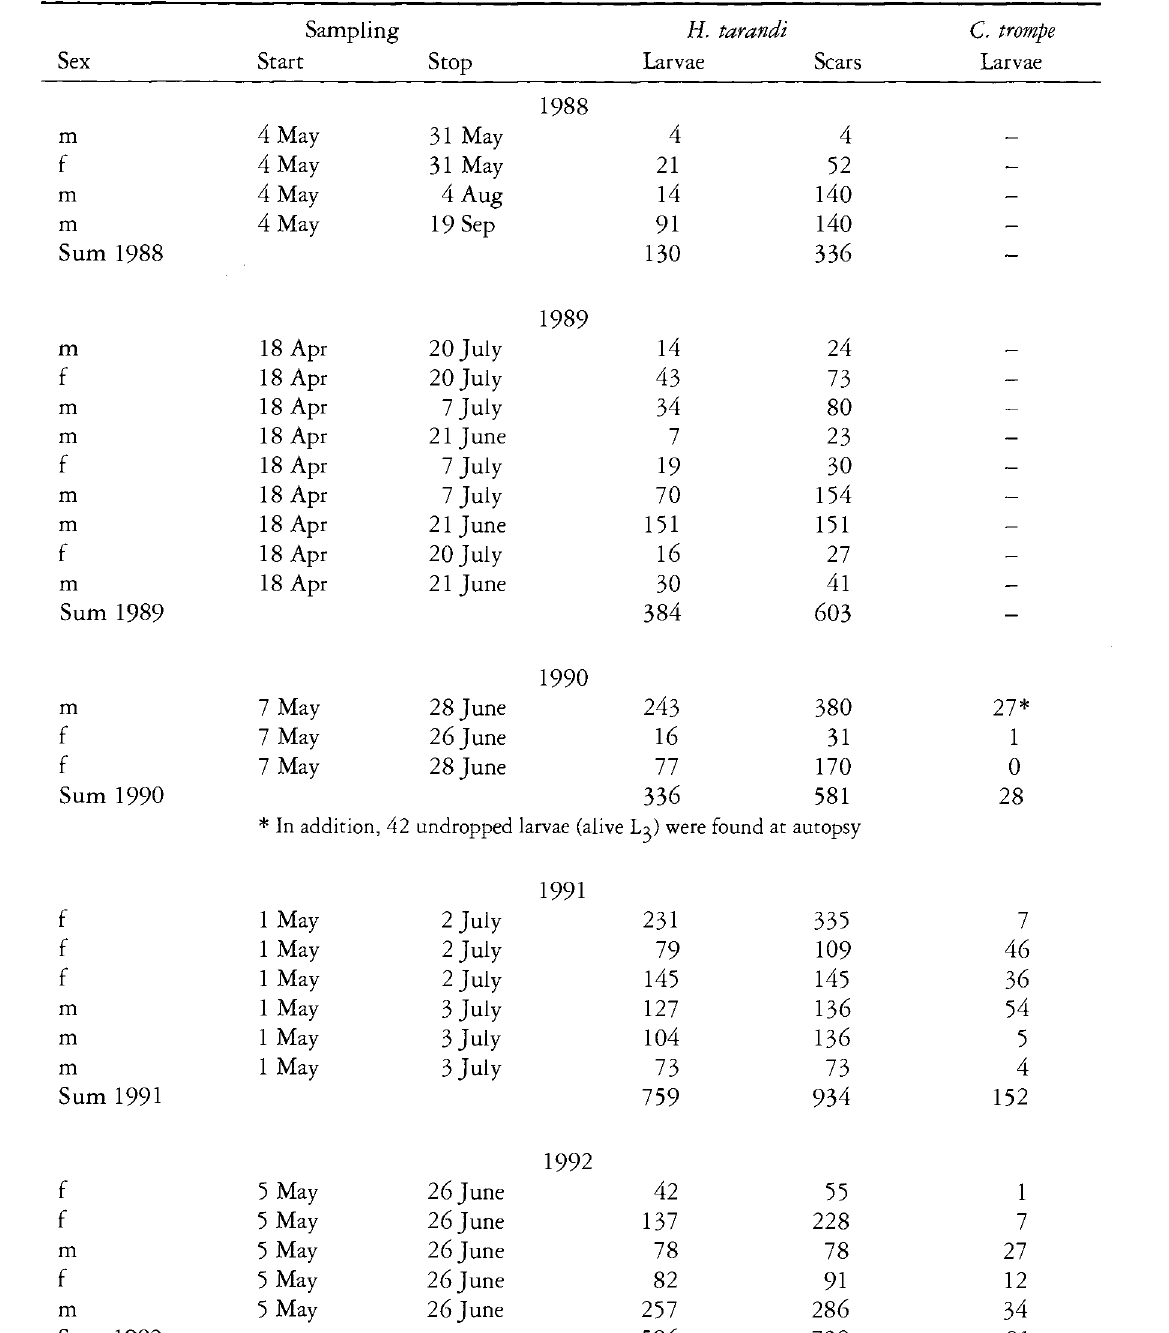
H. tarandi Larvae Scars